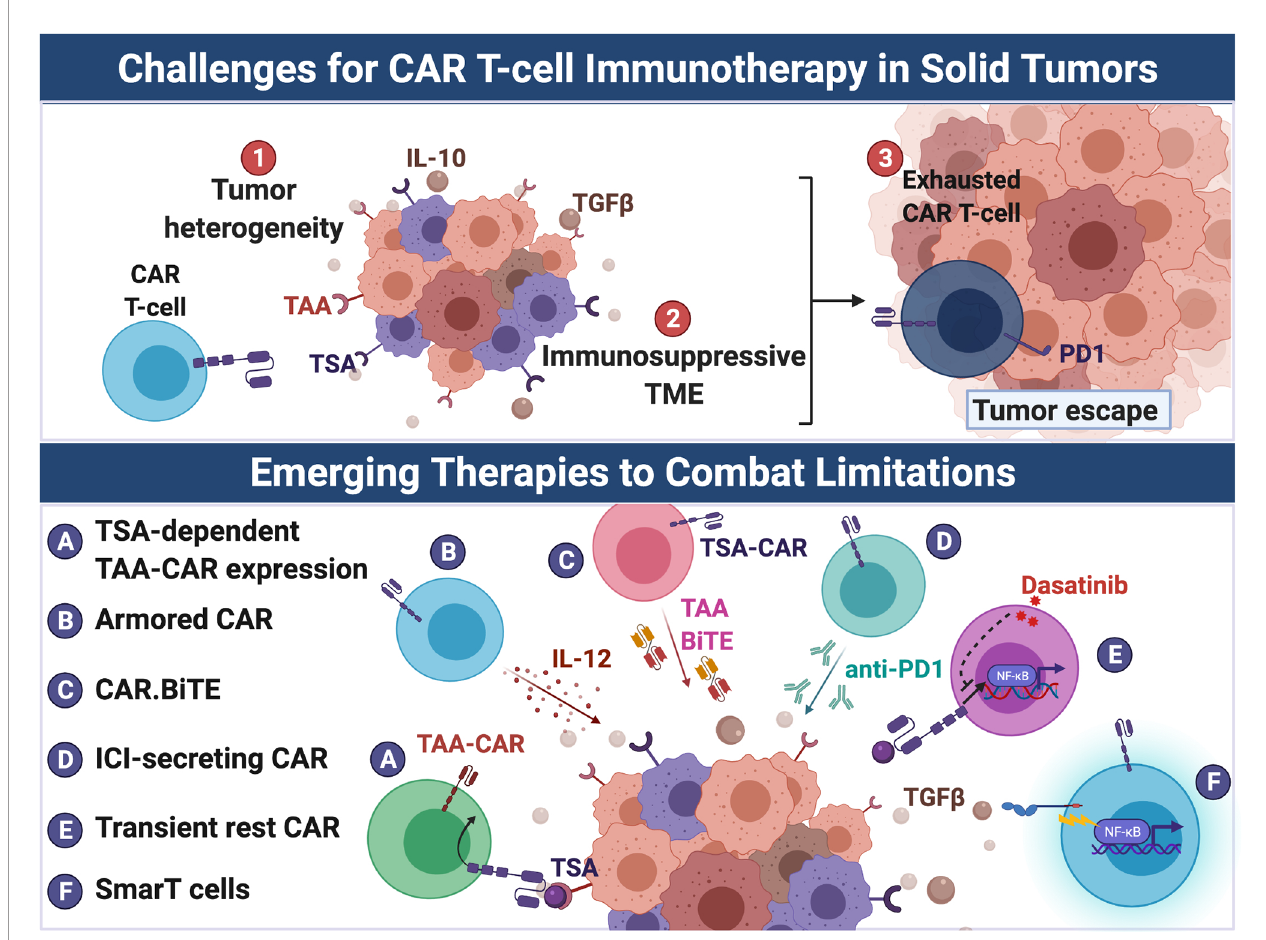
FIGURE 2 | Emerging therapies to overcome challenges to CAR-T cell immunotherapy in solid tumors. CAR T cell therapeutic ef fi cacy has been greatly hindered in solid tumors due to (1) tumor heterogeneity, (2) the immunosuppressive TME, and (3) induction of CAR T cell exhaustion. Several strategies have been developed to overcome these barriers. Tumor heterogeneity results in antigen escape from targeted CAR therapy by antigen-negative tumor cells. To overcome the limitation of tumor heterogeneity, CAR T cells have been engineered to: (A) target multiple antigens including more ubuquitously-expressed TAAs but only after recognition of a TSA, and, similarly, (B) secrete cytokines such as IL-12 that promote endogenous anti-tumor immunity, (C) secrete BiTEs that target TAAs, thus resulting in intratumoral redirection of endogenous T cells to tumor cells. The immunosuppressive milieu (e.g. suppressive cytokines such as TGF- b ) of the TME represses maximal CAR T cell activation. Additionally, solid tumors induce T cell exhaustion of CAR T cells through chronic antigen stimulation and tonic CAR signaling. To counter exhaustion, CAR T cells were: (D) engineered to secreted anti-PD-1 and (E) treated with dasatinib to prevent chronic CAR signaling and enhance CAR activation upon encounter of tumor. (F) To evade the immunosuppressive TME, SmarT CAR T cells were developed by fusing extracellular TGF- b and IL-4 receptors to intracellular co-stimulatory signaling domains, thus converting the action of TGF- b and IL-4 from inhibitory to stimulatory. Created with